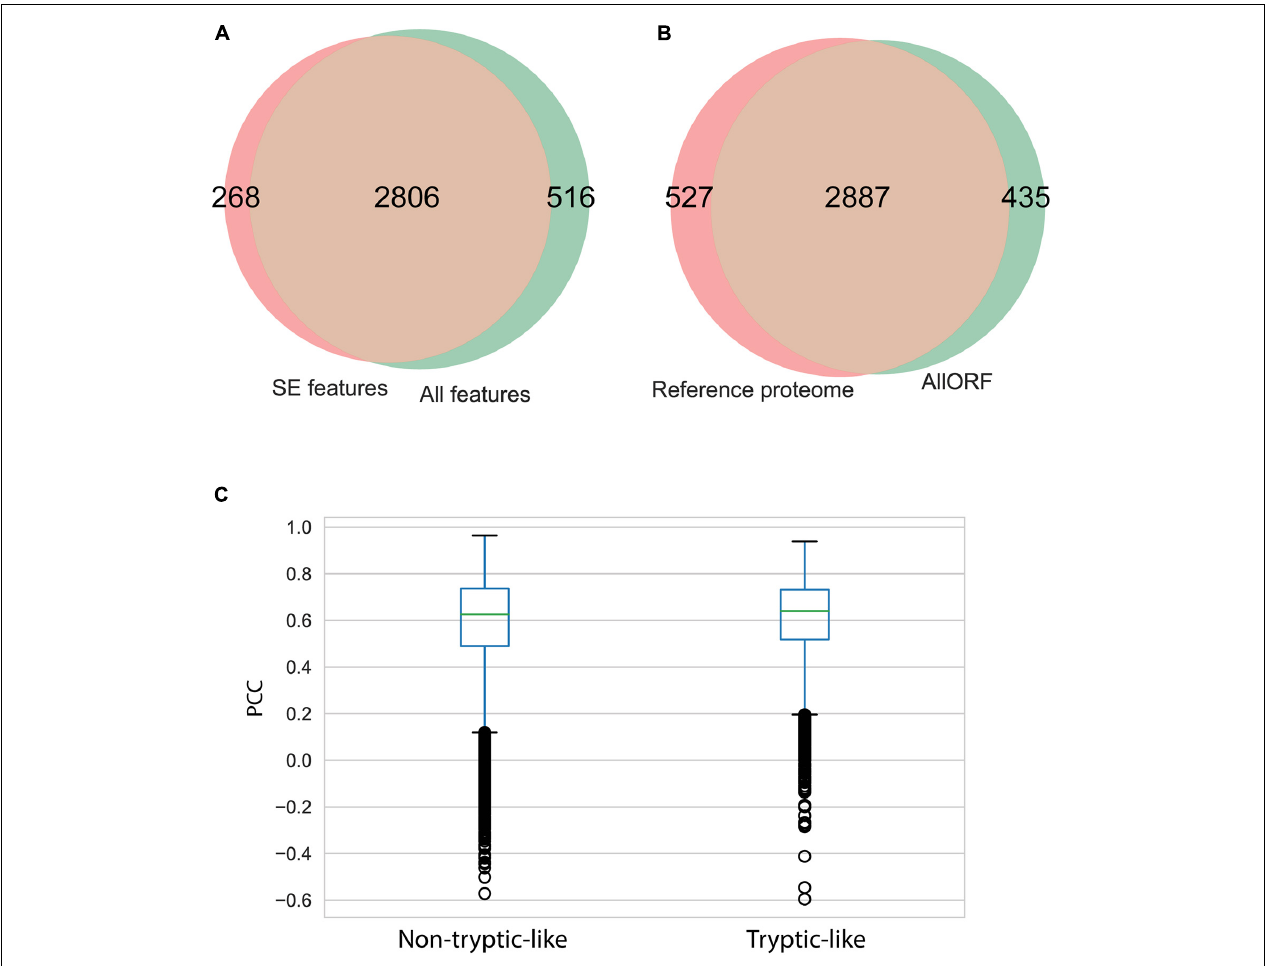
FIGURE 3 | Impact of feature prediction on peptide level. (A) Overlap of unique peptides identified considering “All features” and considering only the “SE features” during proteogenomic searches. (B) Overlap of unique peptides identified searching against the custom proteogenomics database versus the functional proteome (Uniprot). (C) Boxplot of the Pearson correlation coefficient (PCC) of the predicted spectrum intensities by MS 2 PIP and the observed spectrum intensities, for the tryptic peptides (ending on R or K) and non-tryptic-like peptides